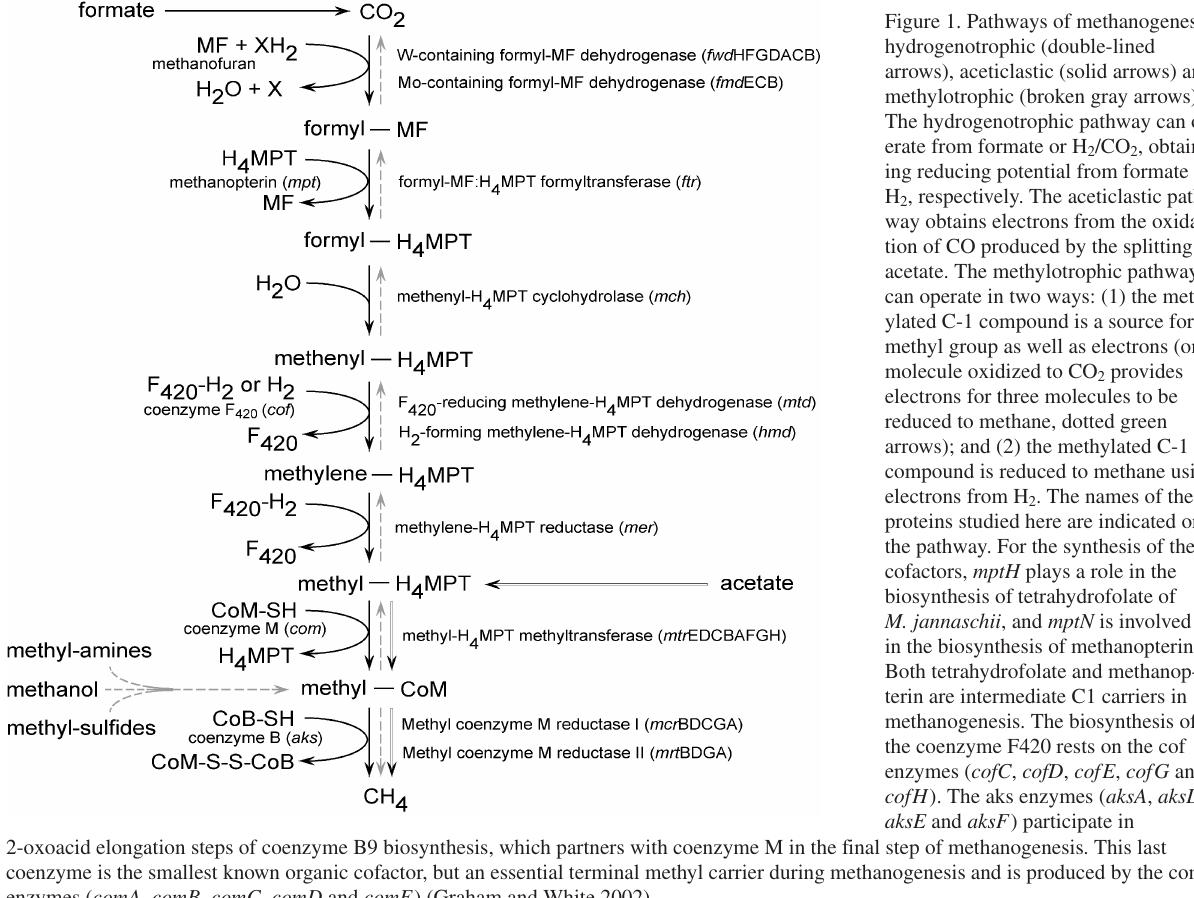
Figure 1. Pathways of methanogenesis: hydrogenotrophic (double-lined arrows), aceticlastic (solid arrows) and methylotrophic (broken gray